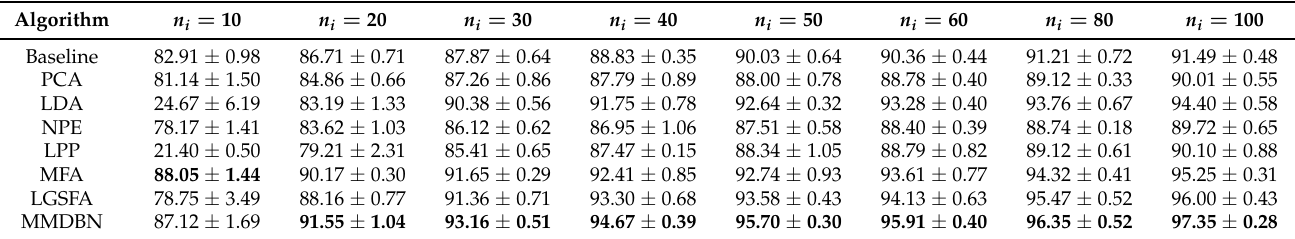
Table 3. The classification results of different DR algorithms for Botswana dataset (overall accuracy ± Std